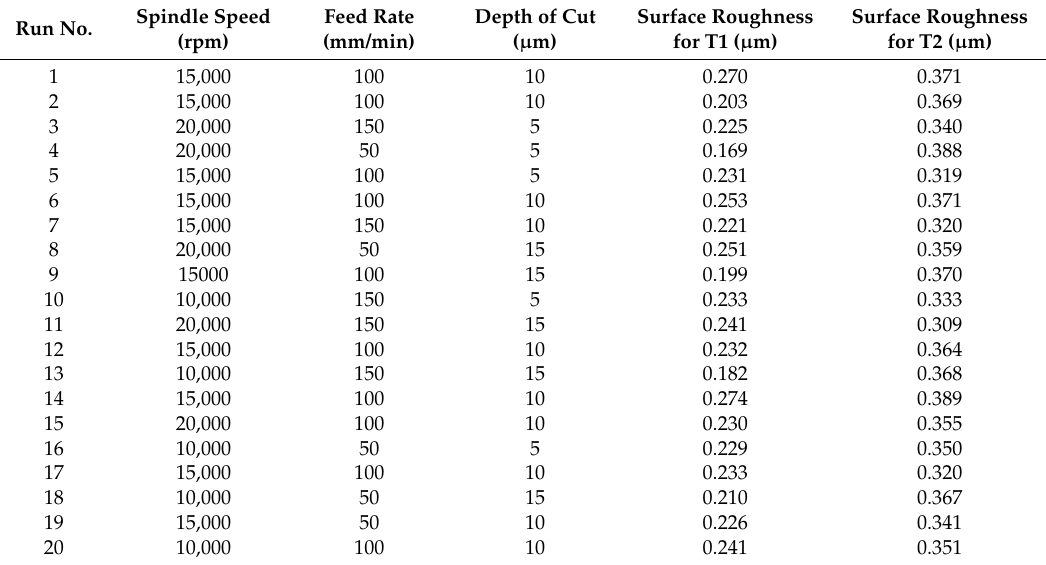
Table 2. Experimental results for surface roughness with different tools.